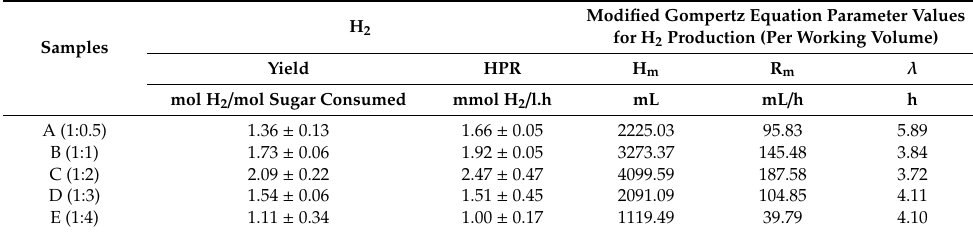
Table 3. Hydrogen productivity obtained from di ff erent concentrations of alginate in batch fermentation.